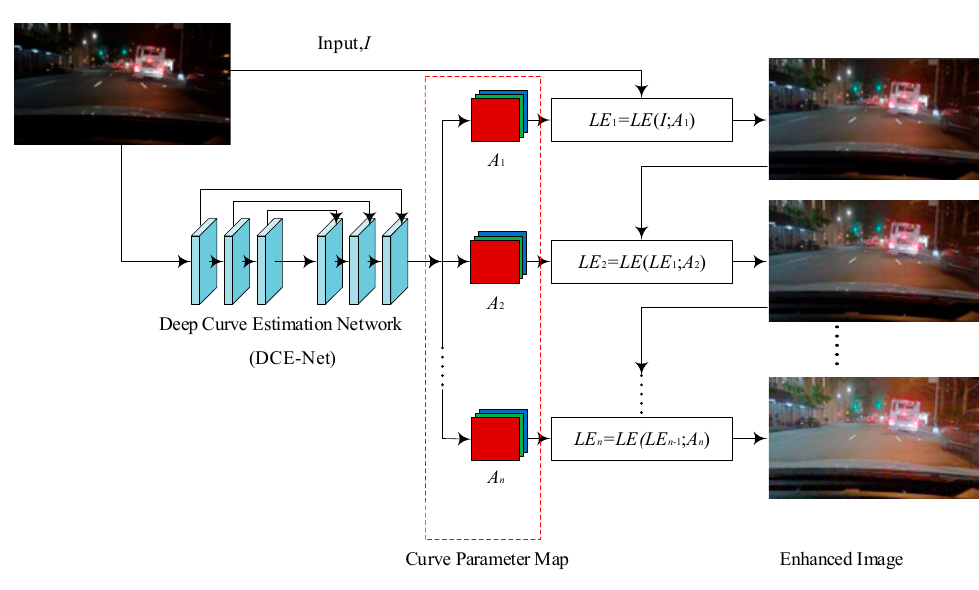
Figure 4. The framework of Zero-DCE.